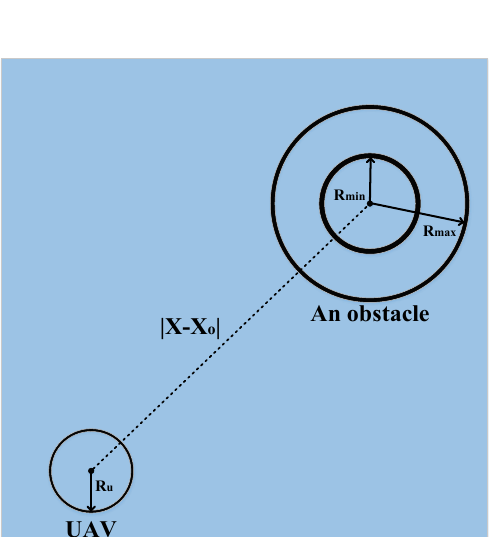
Fig. 1. UAV flight map.